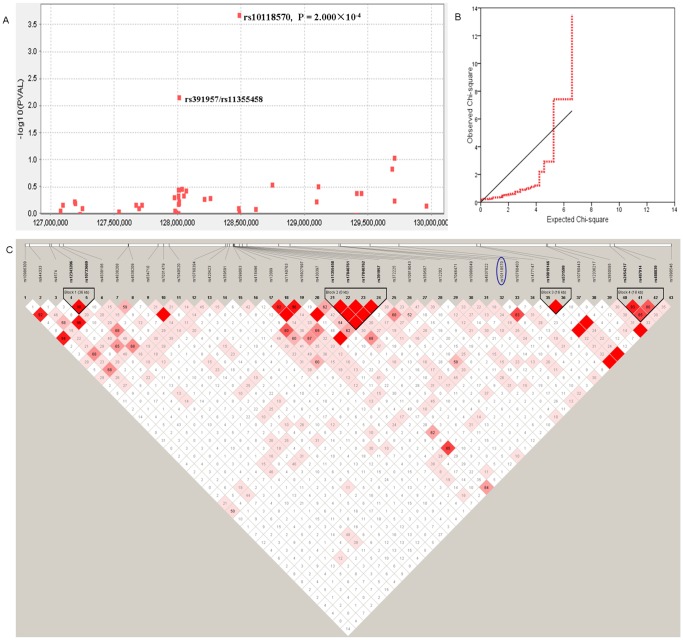
Case-control association and linkage disequilibrium (LD) on chromosome 9q33.3.(A) Manhattan plot displaying the results (−log10 of p-values) of the association of single-nucleotide polymorphisms (SNPs) with S. japonicum infection on 9q33.3 scan with respect to genomic position in the discovery study. The –log10 p values were for the association of each SNP with S. japonicum infection, from two-sided Cochran–Armitage tests for trend. (B) Quantile–quantile (Q–Q) plot for the test statistics of observed Chi-square values against expected Chi-square values were used to examine p value distributions based on the 43 SNPs in a hypothetical chromosome association study in the discovery cohort. (C) LD mapping on the chromosome 9q33.3 locus for the region including the 13 candidate genes (chromosome 9: 127,000,000–130,000,000) in the discovery study was visualized using default settings in Haploview version 4.2. Four blocks are designed according to the internally developed solid spine of LD. Block 1: rs12343206–rs10733669; Block 2: rs11355458–rs17840761–rs17840762–rs391957; Block 3: rs10819146–rs531599; Block 4: rs2454217–rs487914–rs488039. The value within each diamond represents the pairwise correlation between pairs of SNPs (measured as 100× D’) defined by the upper left and the upper right sides of the diamond. The diamond without a number corresponds to D’ = 1. Shading represents the magnitude and significance of D’, with a red-to-white gradient reflecting higher to lower D’ values. The black triangles indicate the location of haplotype blocks. The blue ellipse indicates the potential anti-infective SNP which not belongs to any block.